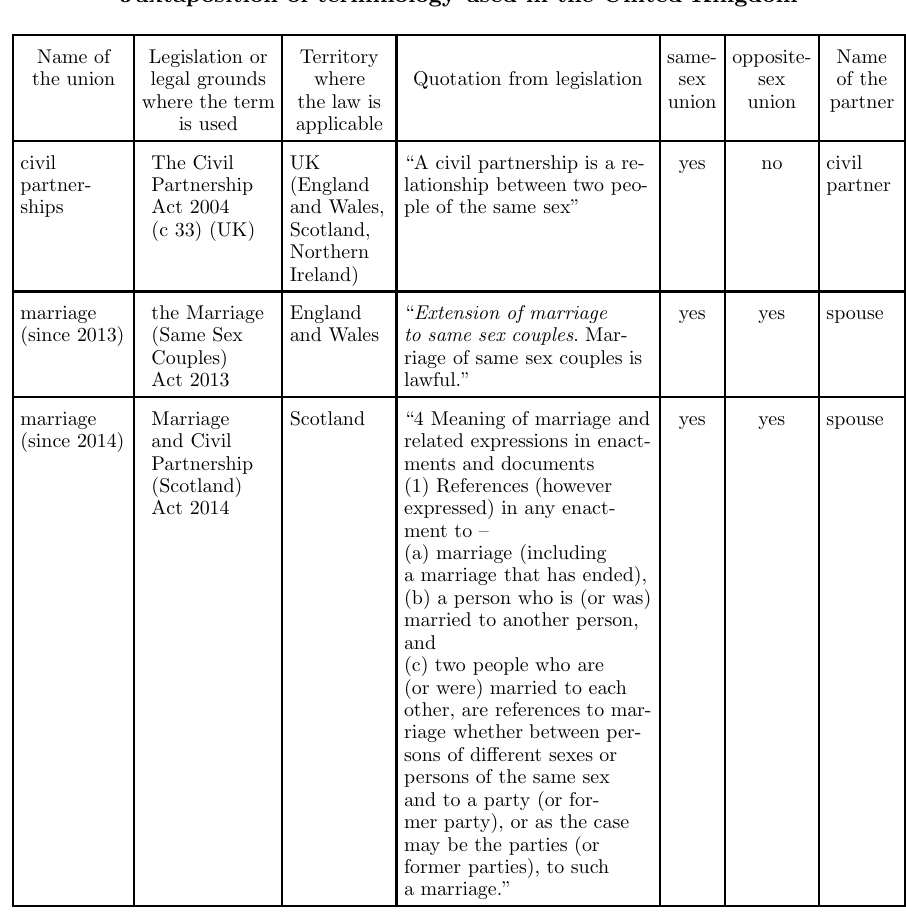
Juxtaposition of terminology used in the United